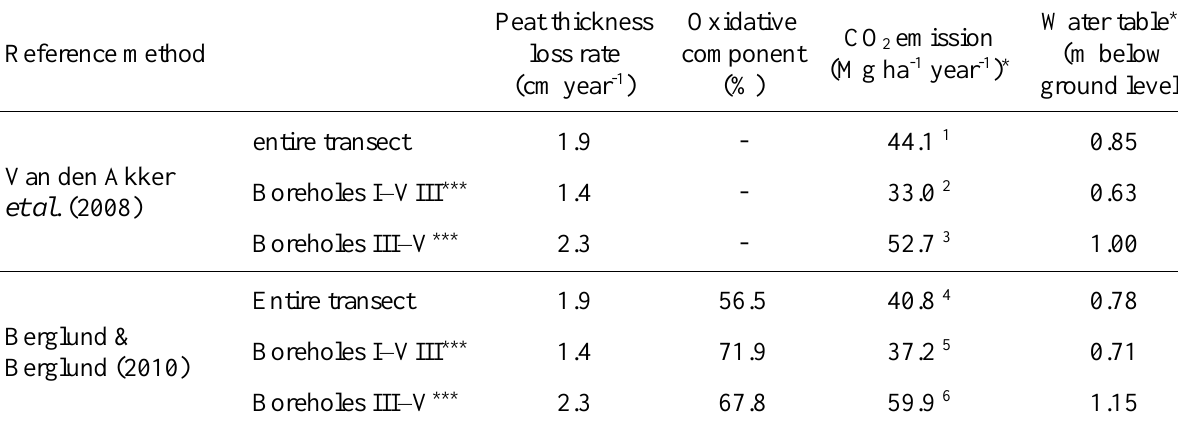
Table 4. Mean peat thickness loss and carbon dioxide emission along the A–B transect in Dublany peatland during the years